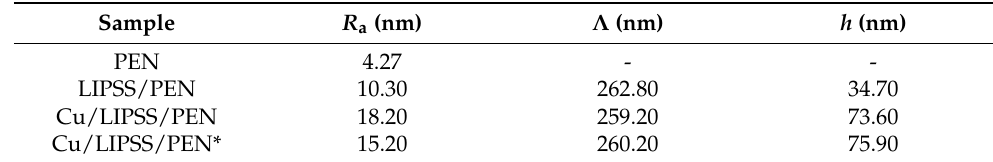
Figure 1. 3D AFM images of pristine, LIPSS/PEN, Cu/LIPSS/PEN, and Cu/LIPSS/PEN* samples with the corresponding values of surface roughness ( R a ). Table 1. Surface characteristics: average surface roughness ( R a ), periodicity ( Λ ), and height ( h ) derived from AFM.